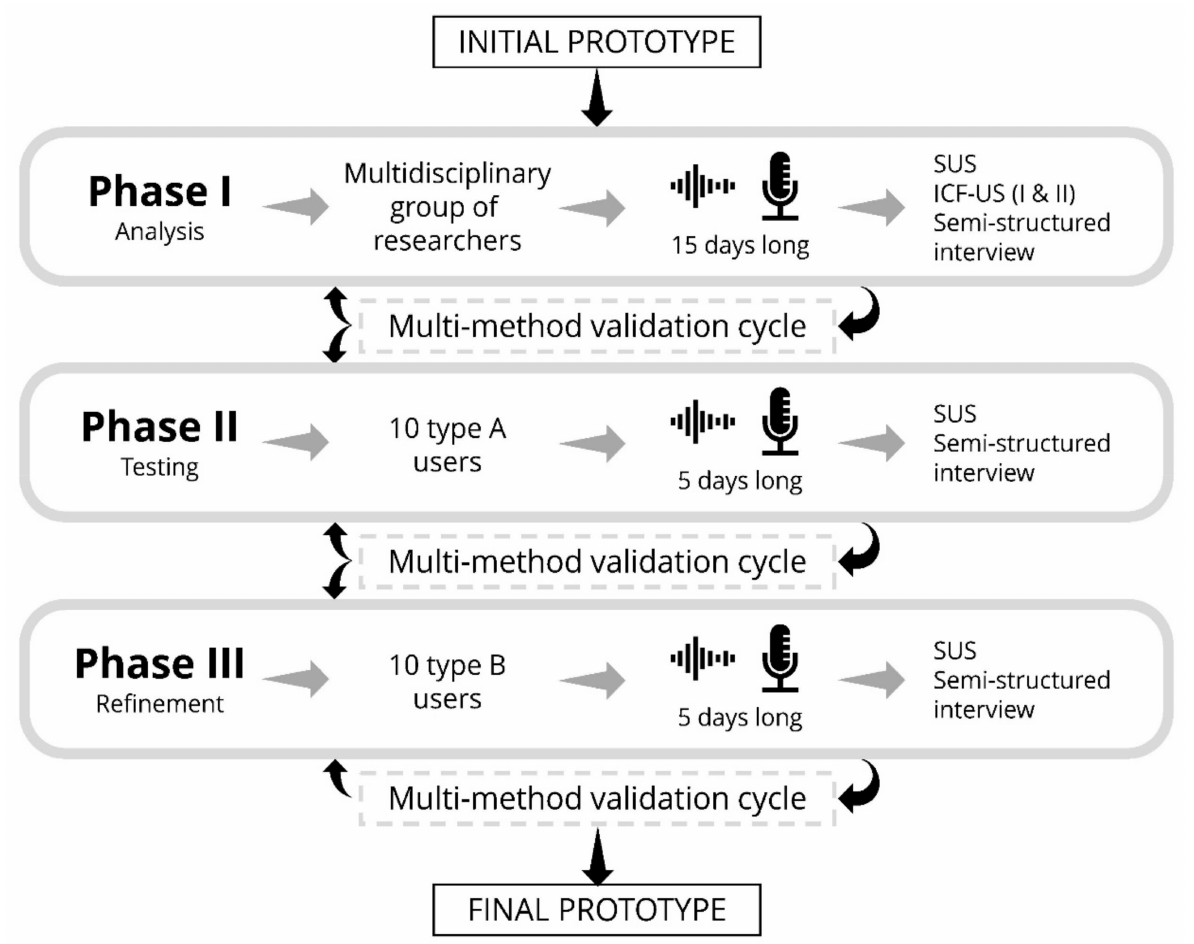
Figure 2. Scheme of the phases for usability evaluation of ACHO. The diagram shows the users involved and estimated duration for each phase, along with the tools that will be used to measure usability and evaluate user experience. The transition from one phase to the next will be controlled by multi-method optimization